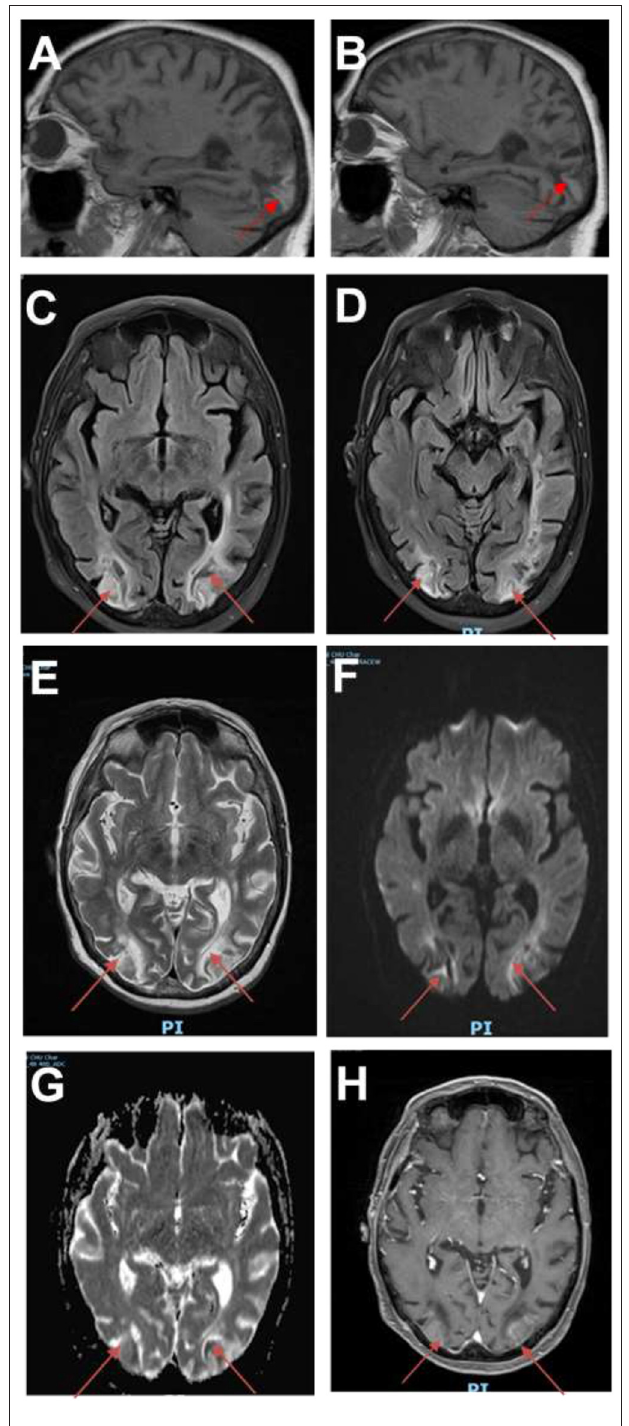
FIGURE 3 | Follow-up images. (A,B) Sagittal T1 MRI showing hyperintensities in both occipital lobes (red arrows). (C,D) MRI fluid attenuation inversion recovery (FLAIR) images showing persistent ischemic-like lesions in the occipital lobes. (E) T2-weighted images showing hyperintense lesions in the occipital lobes. (F) Diffusion images demonstrating restriction in the occipital lobes. (G) MRI apparent diffusion coefficient (ADC) images showing residual restriction in the occipital lobes. (H) MRI angiographic sequences confirming persistent breakdown of BBB in the occipital